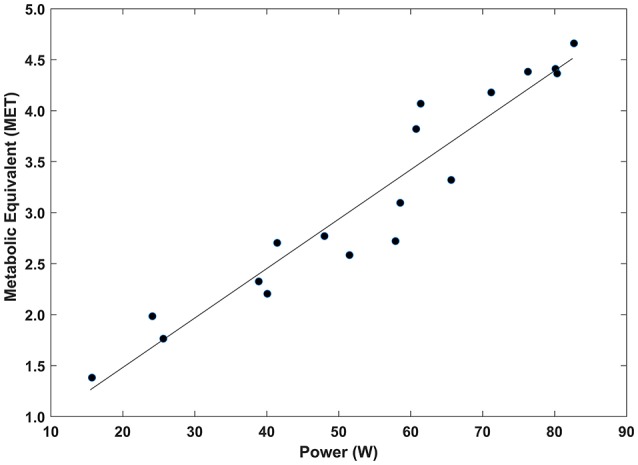
The metabolic equivalent (MET, where 1 MET is defined as the oxygen cost of sitting calmly, equivalent to 3.5 ml/kg/min) plotted as a function of the mechanical power (Ẇ).